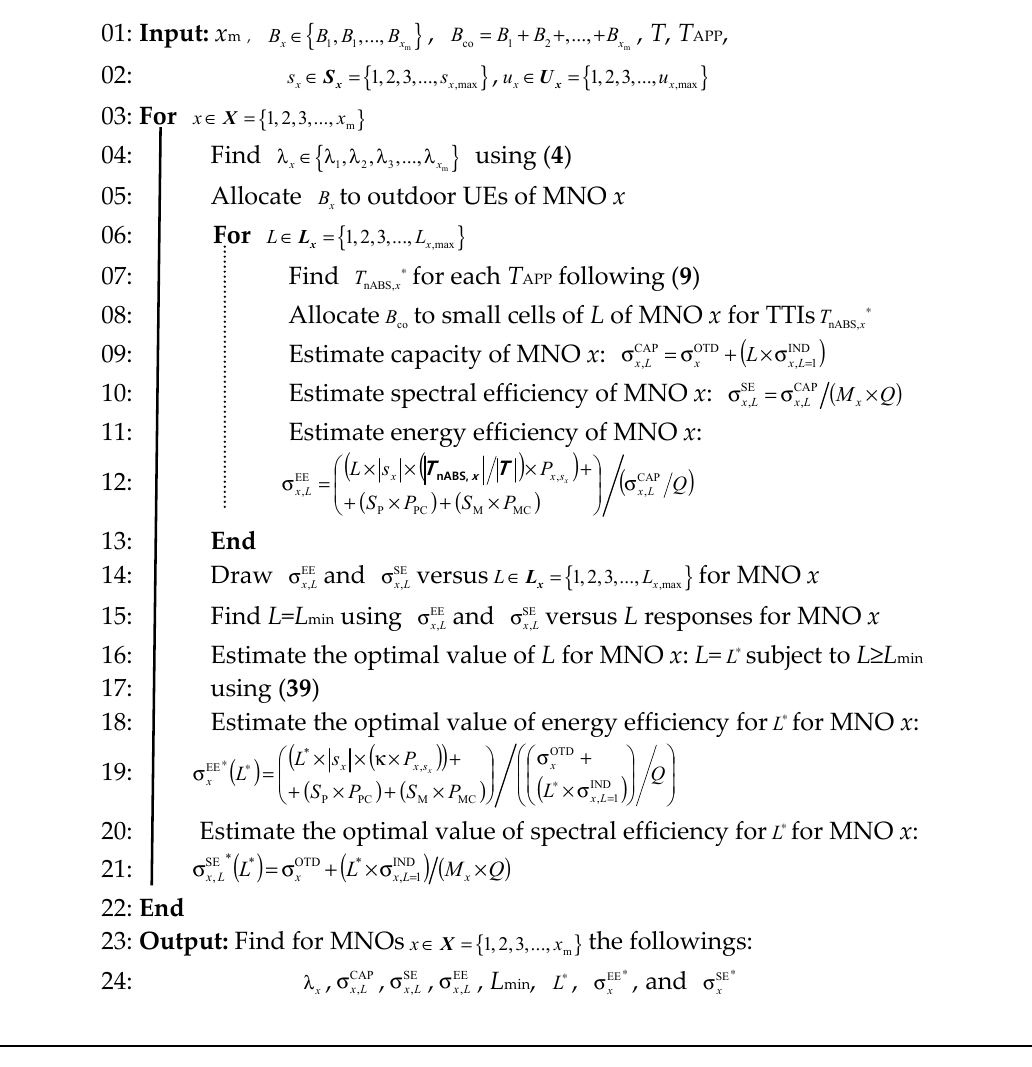
Algorithm 1 Proposed spectrum sharing technique among all MNOs of a country